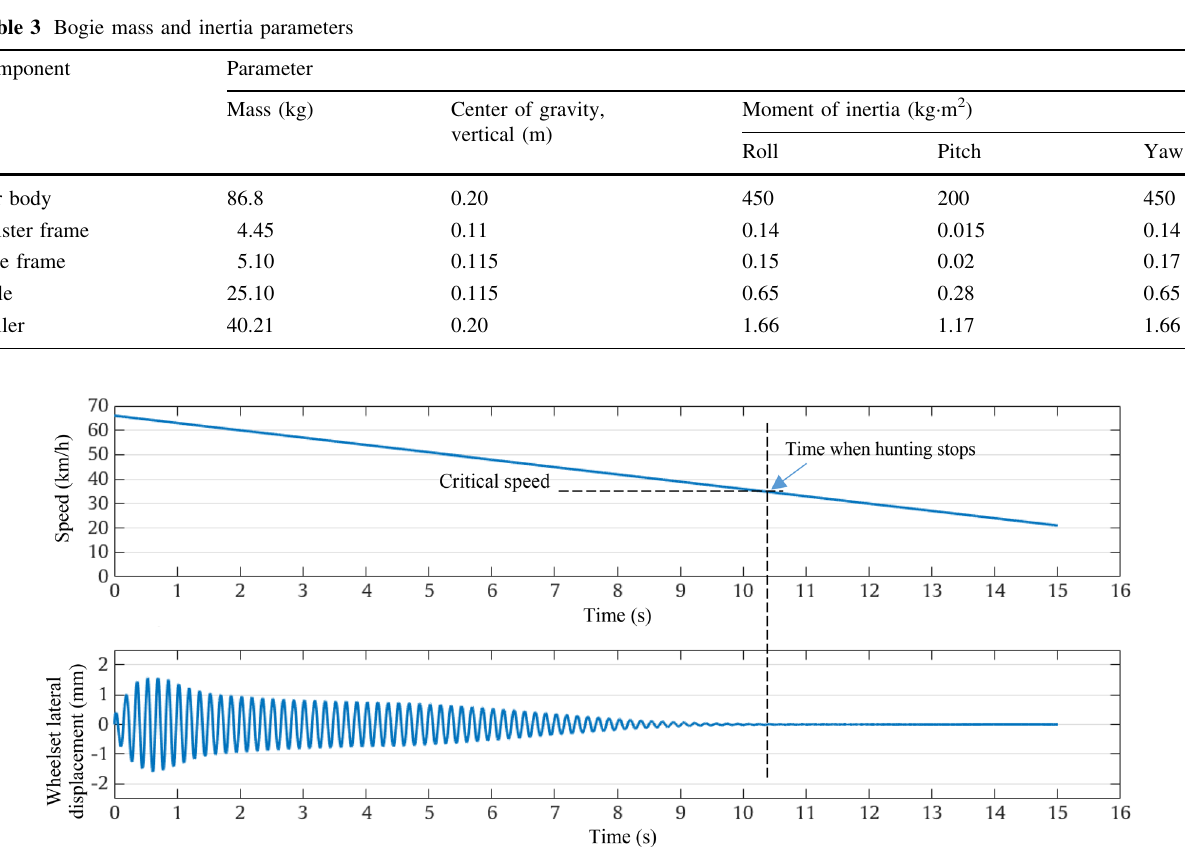
Fig. 5 Hunting from lateral displacement in critical